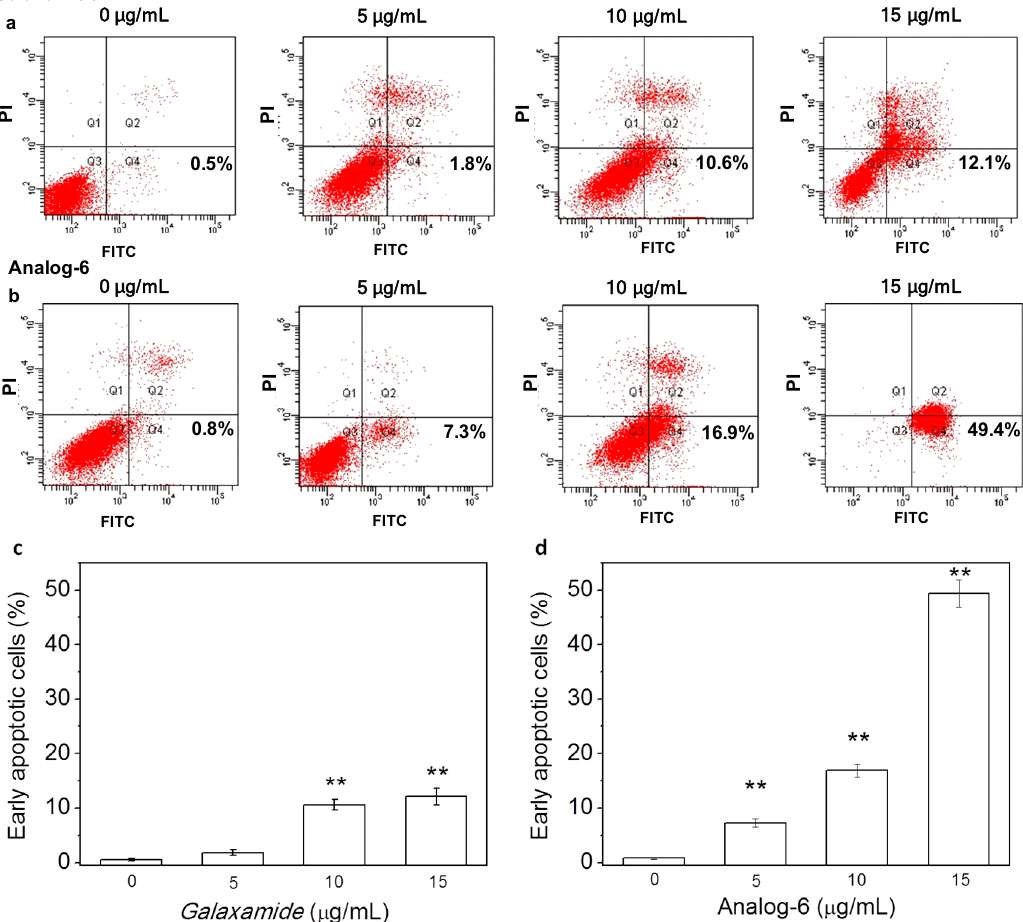
Figure 5. Flow cytometry results of HepG 2 cells stained by Annexin V-fluorescein isothiocyanate (FITC) and propidium iodide (PI) after 48 h of exposure to 0, 5, 10 and 15 µg/mL Galaxamide ( a ) and Analog-6 ( b ); Comparison of the percentage of early apoptotic cells induced by Galaxamide ( c ) and Analog-6 ( d ); ** p < 0.01.